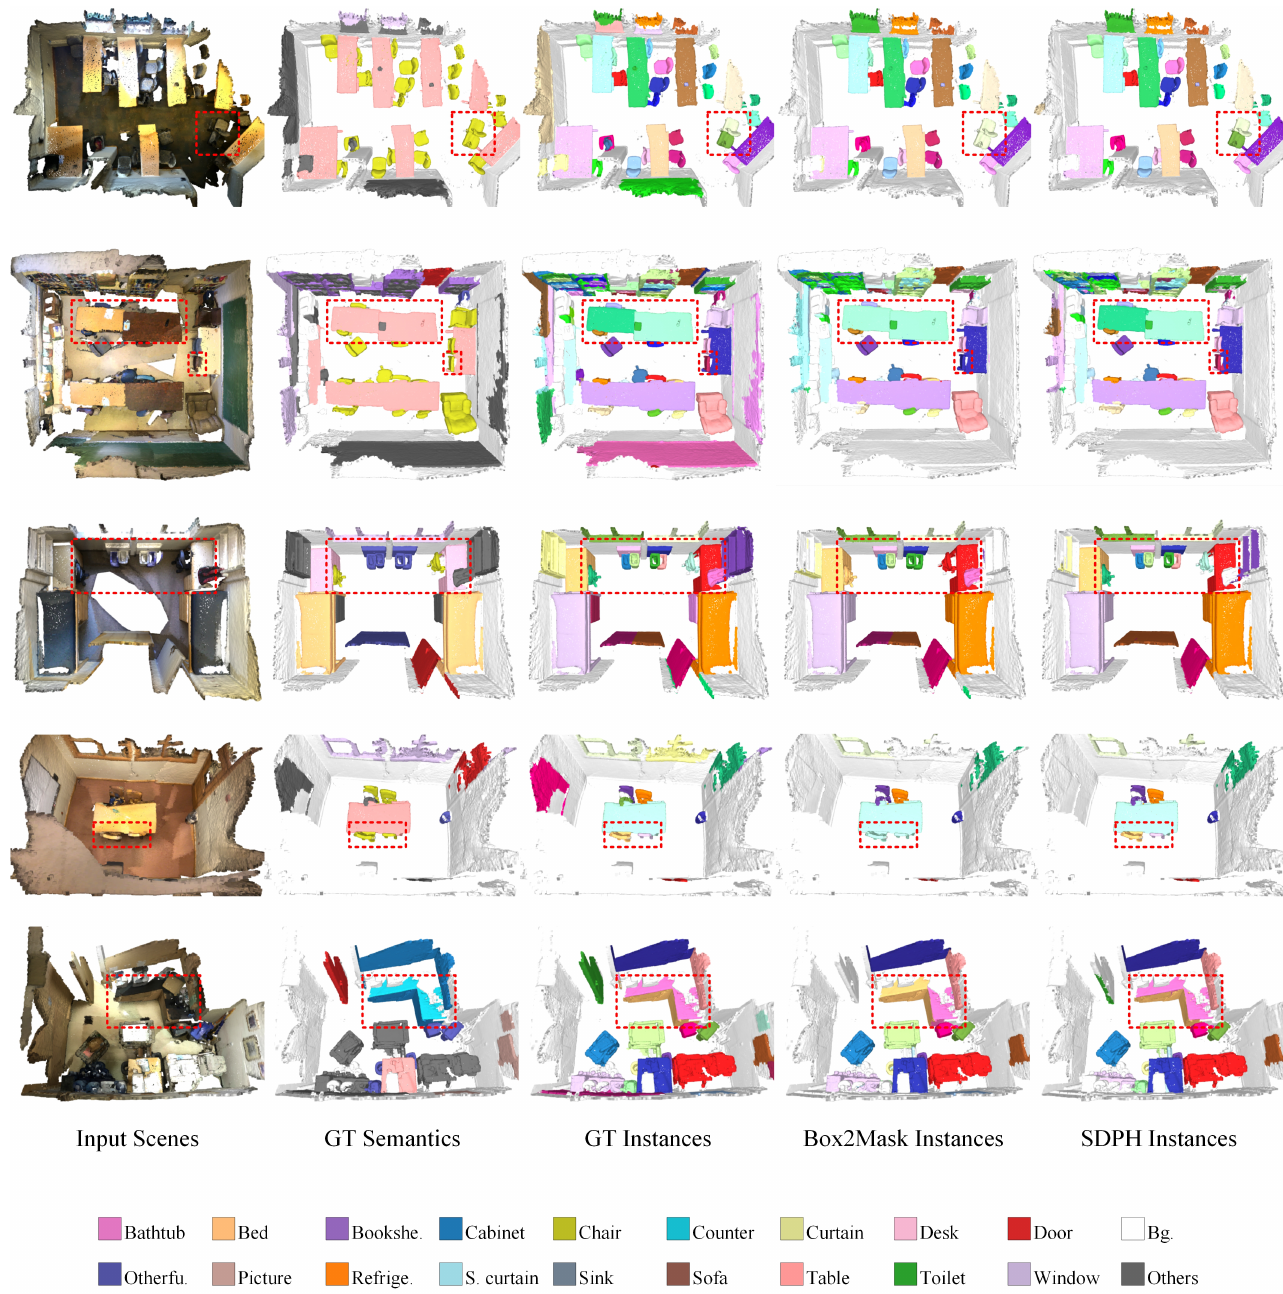
Figure 7. Qualitative comparison at a noise rate of 40% on ScanNet-v2. The legend is employed to distinguish among different semantic meanings, while the individual instances are randomly colored. The key differences are marked out with red dashed